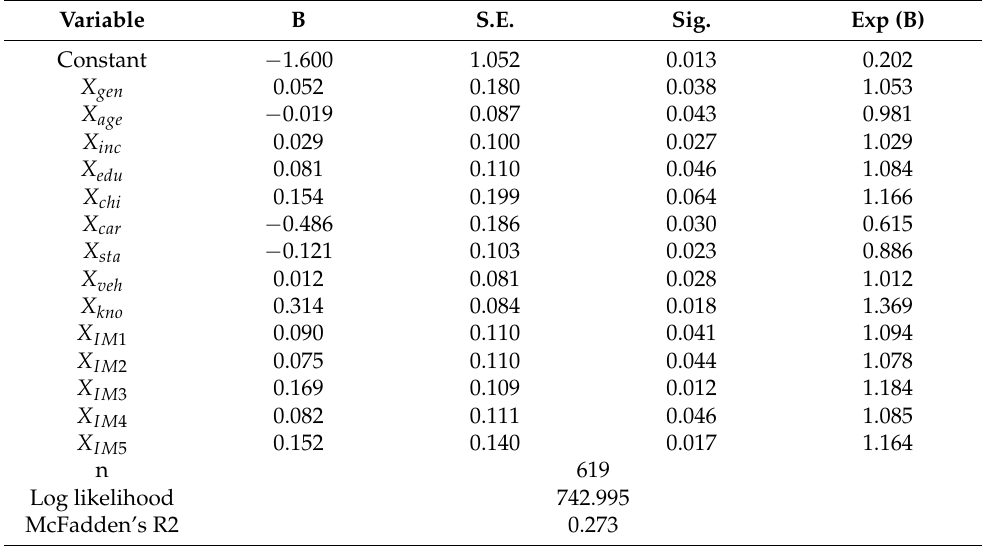
Table 7. Parameter fitting results of binary logit model without attitudinal variables.